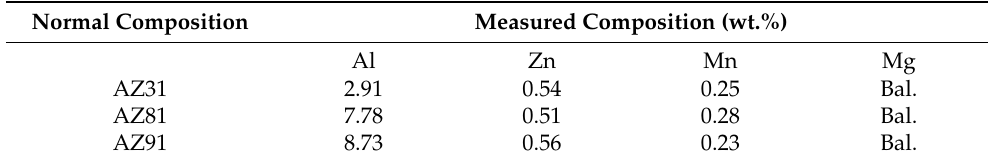
Table 2. The compositions of studied alloys. Normal Composition Measured Composition